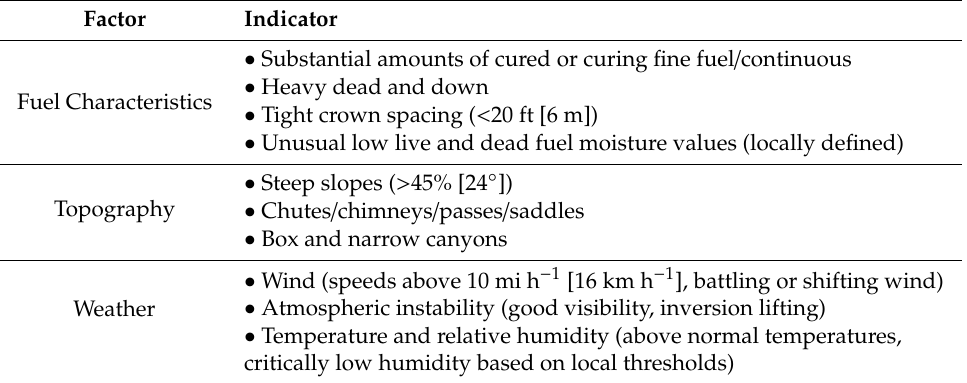
Table 1. Fire environment factors and a partial list of their respective indicators used to assess fire behavior-related dangers as identified in the Look Up, Look Down, Look Around training curriculum [10] and outlined by National Wildfire Coordinating Group